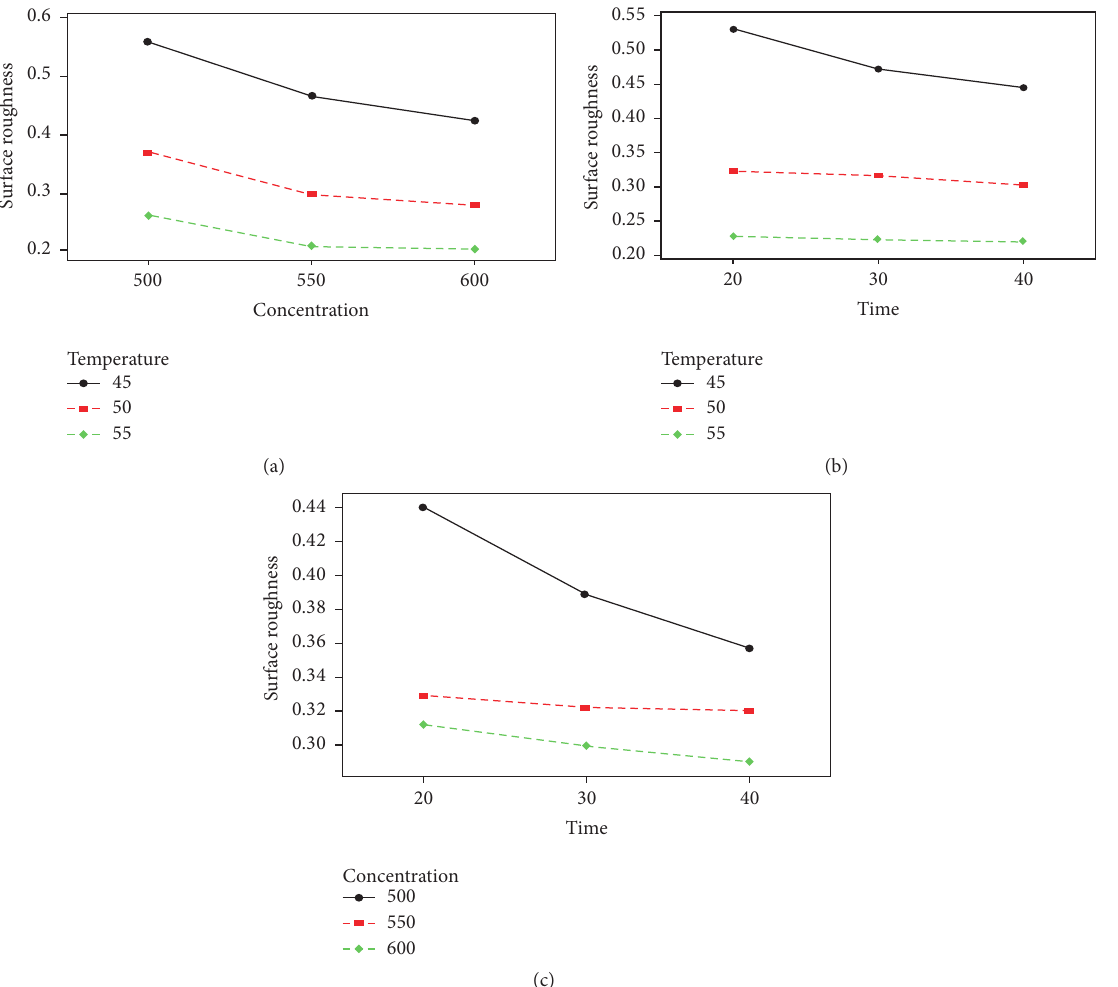
Figure 8: Interaction plots: (a) temperature and concentration, (b) temperature and time, (c) etchant concentration and time.